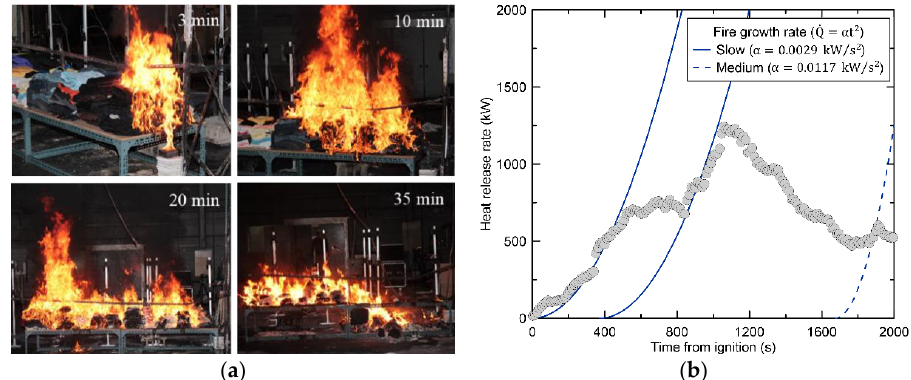
Figure 6. Fire spread pattern and heat release rate of clothing placed on stalls: ( a ) Sequential photographs of fire spread over time; ( b ) measured heat release rate.